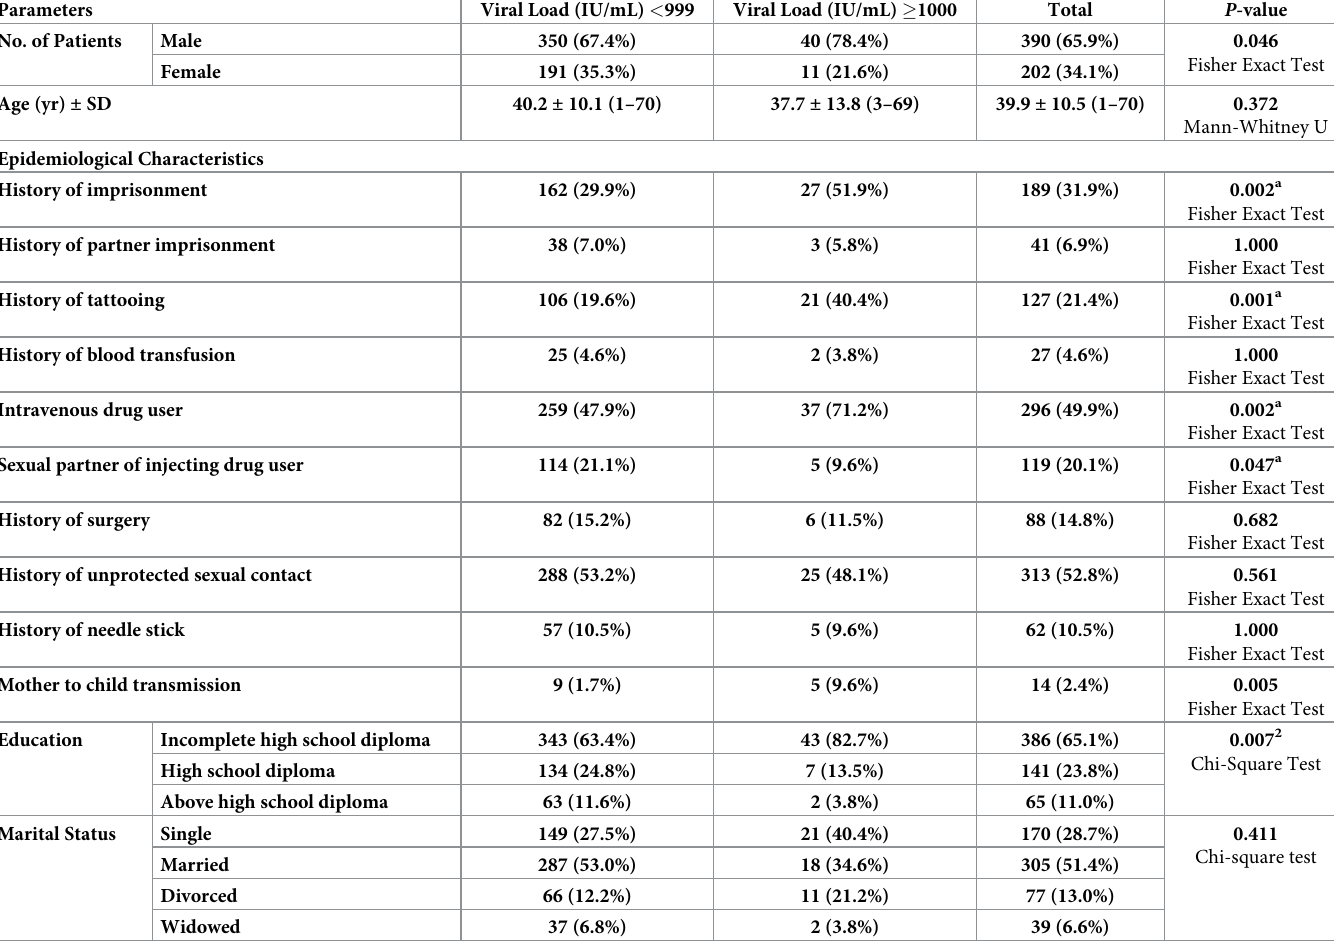
Table 3. Demographic and epidemiological characteristics of patients with human immunodeficiency virus